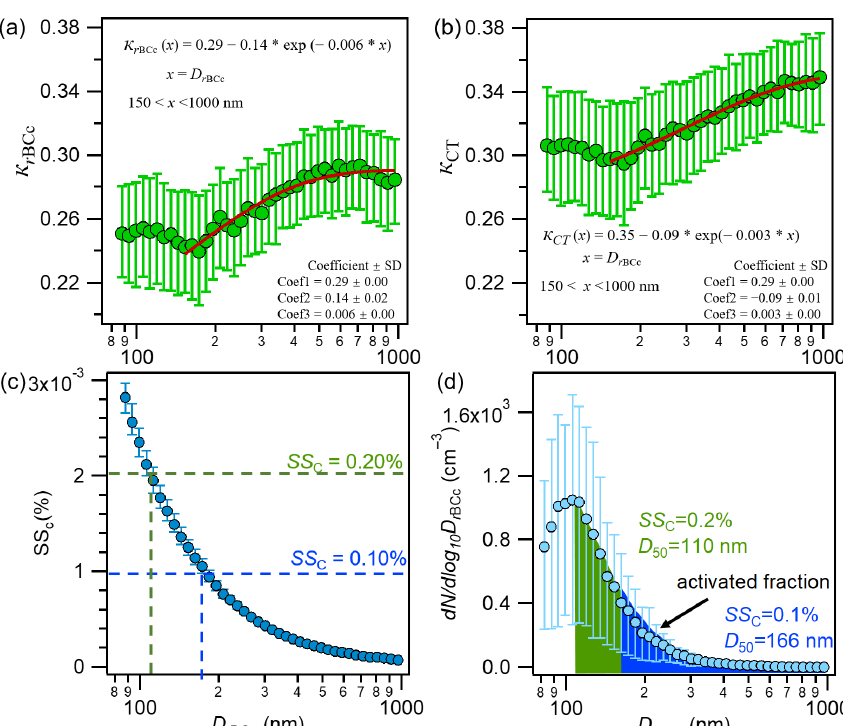
Figure 12. Campaign-average size-resolved hygroscopic parameters for rBCc particles ( κ rBCc ) and (a) for their coatings ( κ CT ) (b) (the red lines are exponential fits of the data for 150–1000nm). (c) Campaign-average size-resolved critical supersaturation (SS C ) and (d) the predicted activated fraction of the rBCc-particle number concentration based on D 50 at SS C values of 0.1% (166nm) and 0.2% (110nm) (the solid circles are mean values and the upper and lower lines are the 75th and 25th percentiles, respectively).